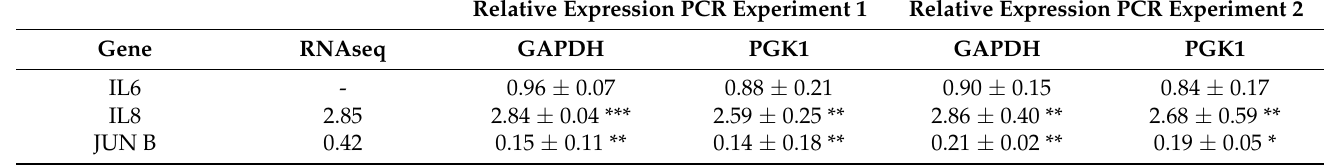
Table 8. Effects of NPs on the expressions of the different genes. T98G human glioblastoma cells were exposed to 20 µ g/mL of TiO 2 -NPs for 72 h, as described in Section 4.4. Then, RNA was isolated as described in Section 4.8 to be reverse- transcribed and quantified by real-time quantitative polymerase chain reactions (RT-PCR), as described in Section 4.11, using glyceraldehyde 3-phosphate dehydrogenase (GAPDH) and phosphoglycerate kinase 1 (PGK1) as the housekeeping genes. The RNA sequencing (RNAseq) data were taken from the respective log 2 (fold change (FC)), as shown in Supplementary Materials Table S2. * = statistically different from the control for p < 0.05. ** = statistically different from the control for p < 0.01. *** = statistically different from the control for p < 0.001 IL =